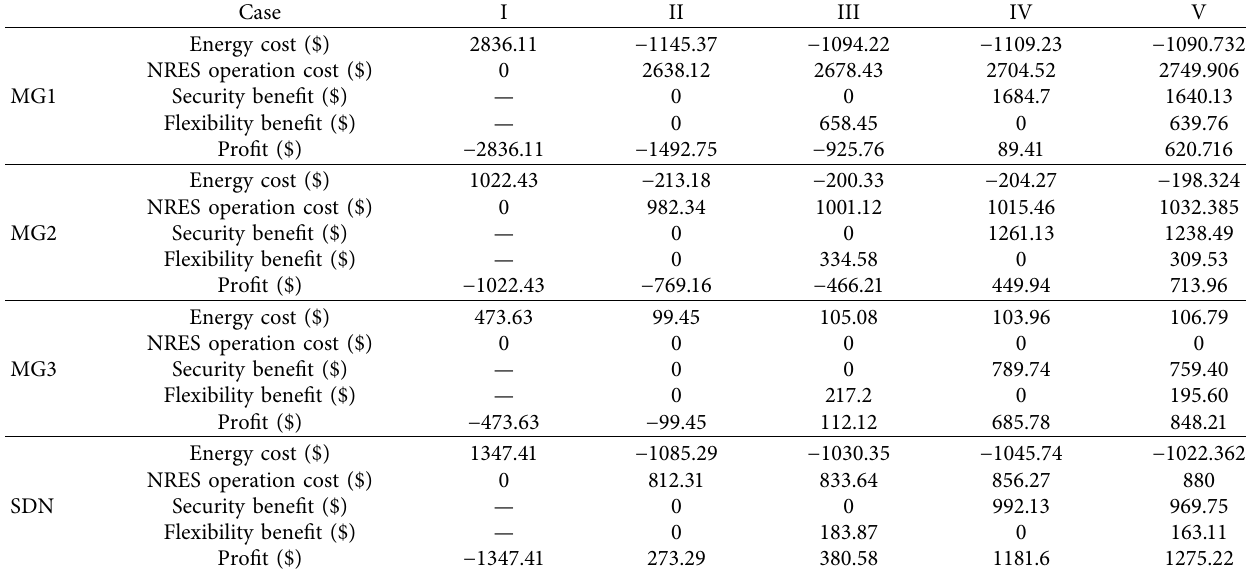
Table 6: The values of different economic indices in MGs and